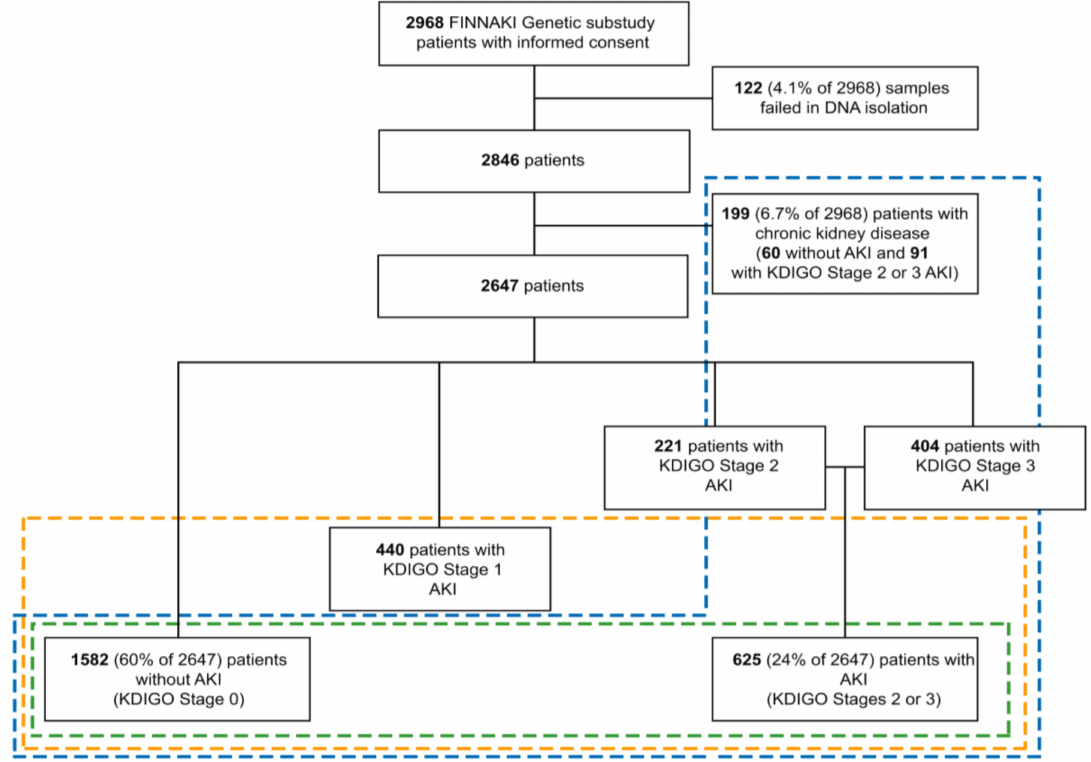
Figure 1. Study flowchart. Abbreviations: FINNAKI; Finnish Acute Kidney Injury; DNA, deoxyribonucleic acid; AKI, acute kidney injury; KDIGO, Kidney Disease: Improving Global Outcomes. Table 1. Demographics of altogether 2647 patients in the FINNAKI genetic substudy after excluding patients with maintenance dialysis. Data are presented according to presence of severe AKI (KDIGO stage 2 or 3, n = 625), presence of all stage AKI (KDIGO stage 1, 2, 3, n = 1065), or absence of AKI (KDIGO stage 0, n =